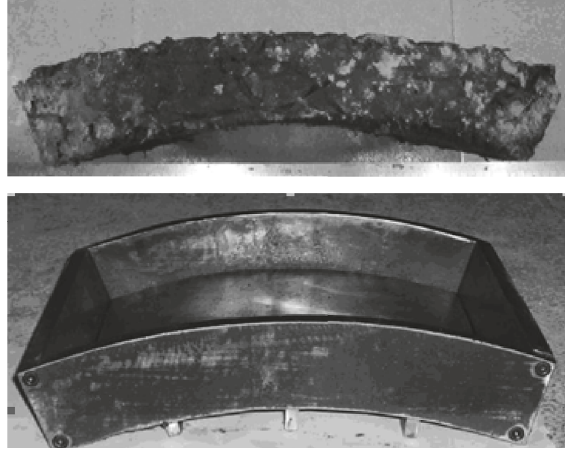
Figure 4: Curved specimen and its